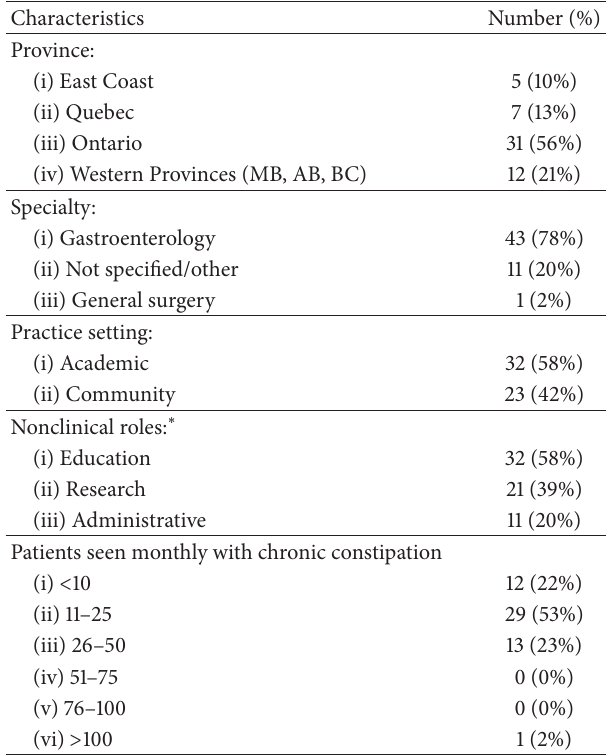
Table 1: Respondent